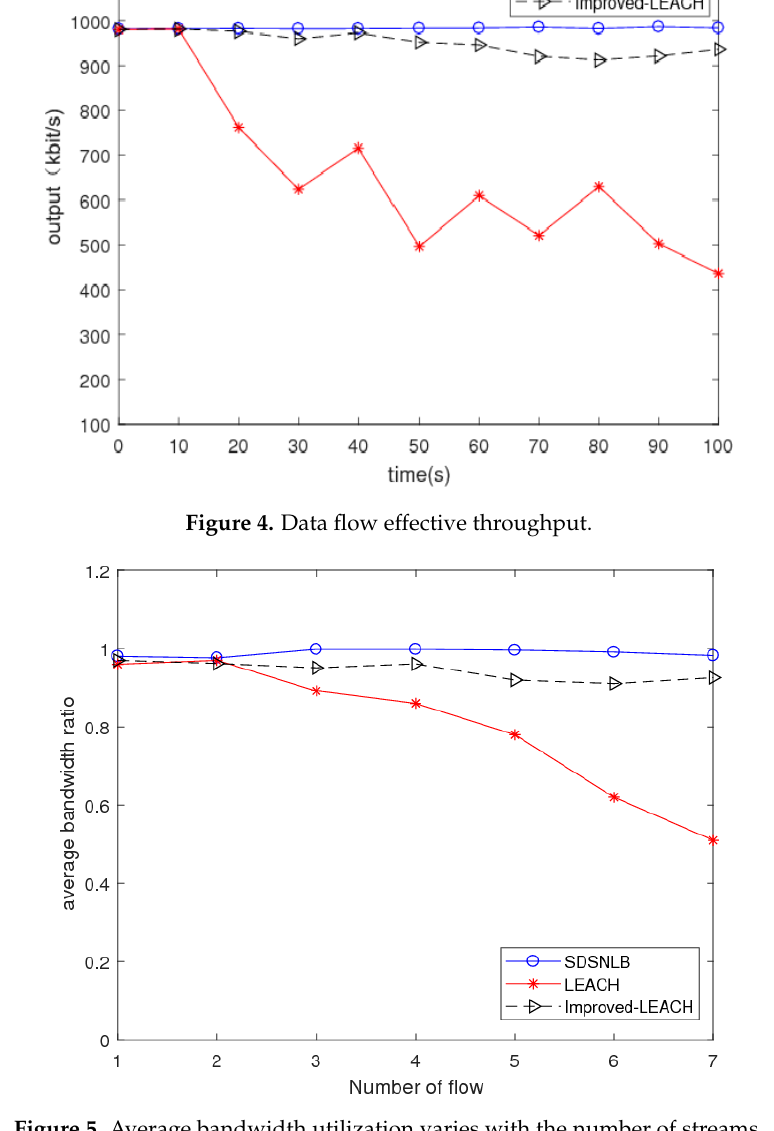
Figure 5. Average bandwidth utilization varies with the number of streams.